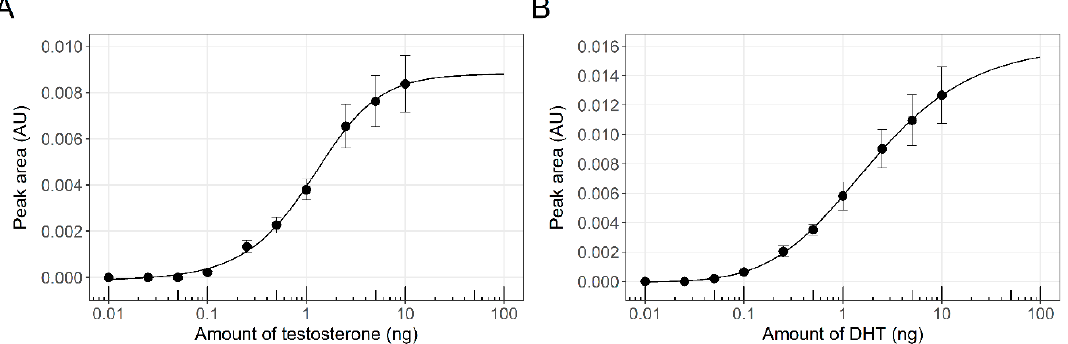
Figure 6. Dose-response curves of androgenic reference compounds testosterone ( A ) and 5 α -Androstan-17 β -ol-3-one (DHT, B ), as derived from the experiment described in Figure 5 above. Fluorescent signal intensity determined by the peak area detected using a TLC Scanner 4 ( λ ex = 396 nm, cut-off filter of 400 nm) was plotted against the applied amount. Data points represent the mean values of the signal, and the error bars show the respective standard error (n = 3). The solid lines were fitted to the data using a five-parameter log-logistic function.